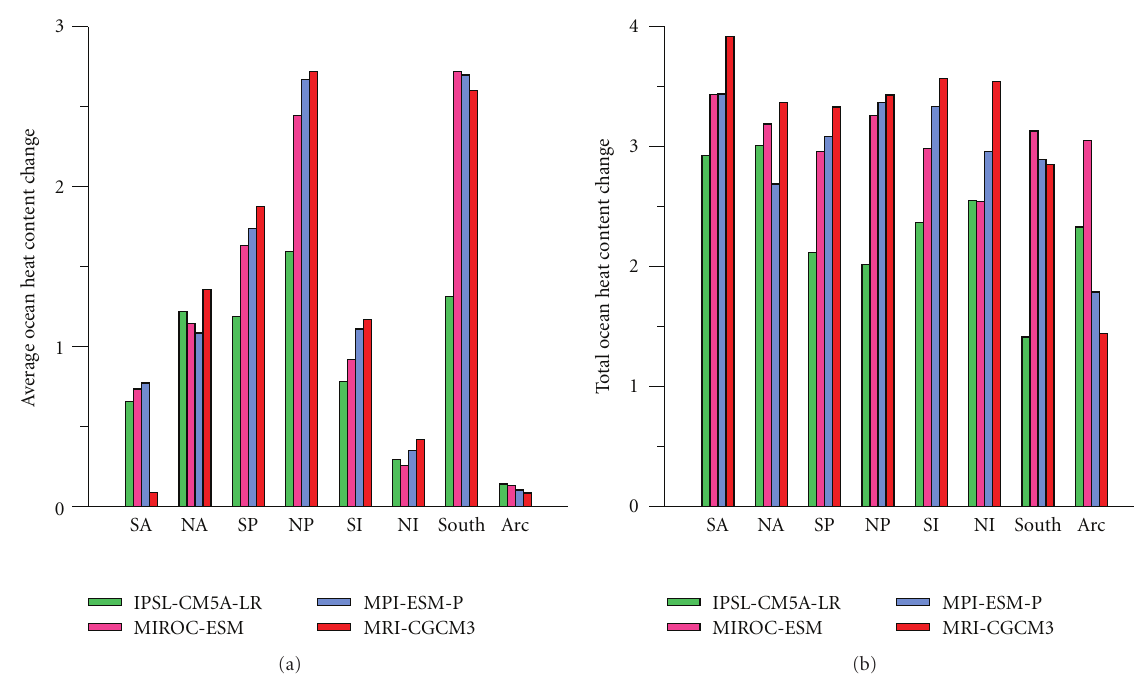
Figure 5: Ocean heat content change in ocean basins. (a) Average OHC change ( × 10 10 Jm − 2 ) and (b) total OHC change ( × 10 24 J). Cooling in the North Pacific and Southern Ocean di ff ers in magnitude among the four models. SA—South Atlantic, NA—North Atlantic, SP—South Pacific, NP—North Pacific, SI—South Indian, NI—North Indian, South—Southern Ocean,